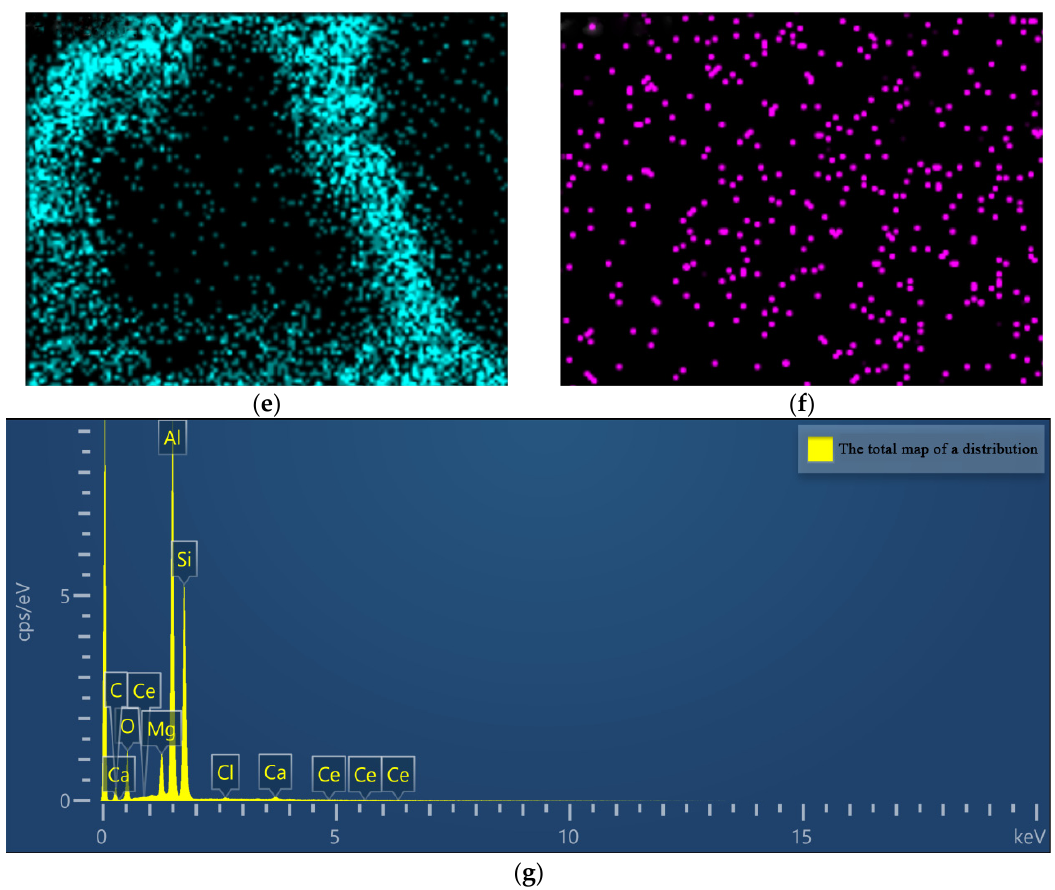
Figure 10. Mapping and EDS of Ce-rich metal precipitates. ( a ) Detecting position, ( b ) Al element, ( c ) Si element, ( d ) Mg element, ( e ) O element, ( f ) Ce element and ( g ) EDS analysis.